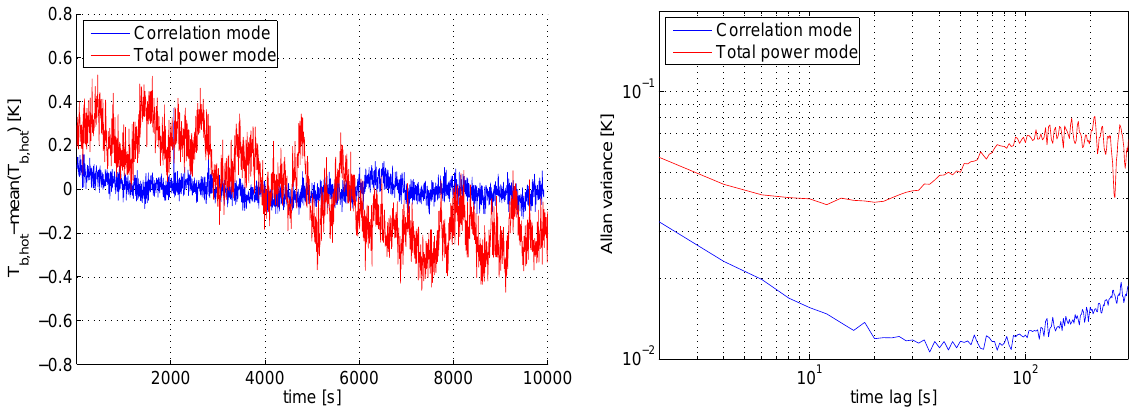
Fig. 5. Stability of the receiver of MIAWARA-C in the correlation- and the total power mode. Timeseries of the deviation of the calibrated data from the mean value (left) and Allan variance (right), τ =2s and 1ν